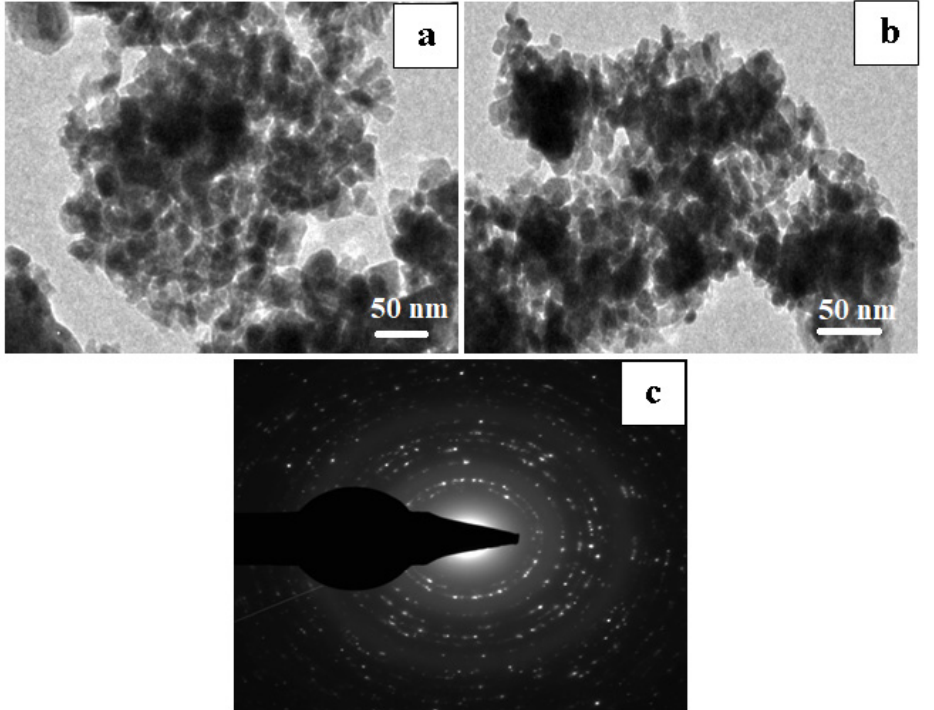
Figure 6. HR-TEM images of ( a ) MnFe 2 O 4 , ( b ) MnCe 0.3 Fe 1.7 O 4 and SAED pattern of ( c ) MnCe 0.3 Fe 1.7 O 4 NCs. ( c ) MnCe 0.3 Fe 1.7 O 4